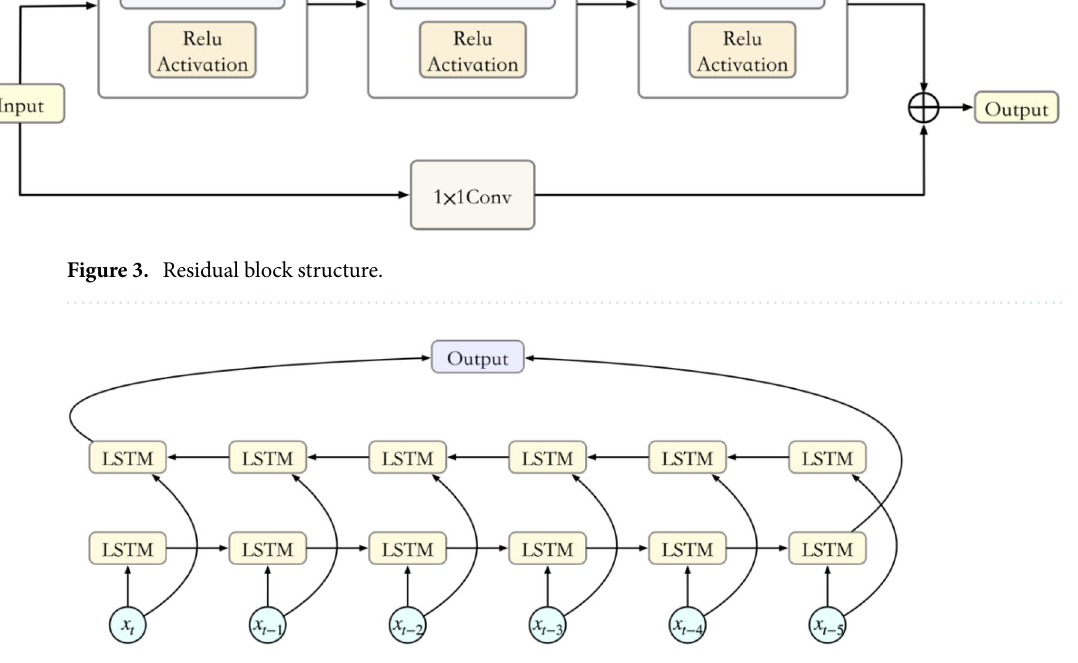
Figure 4. BiLSTM